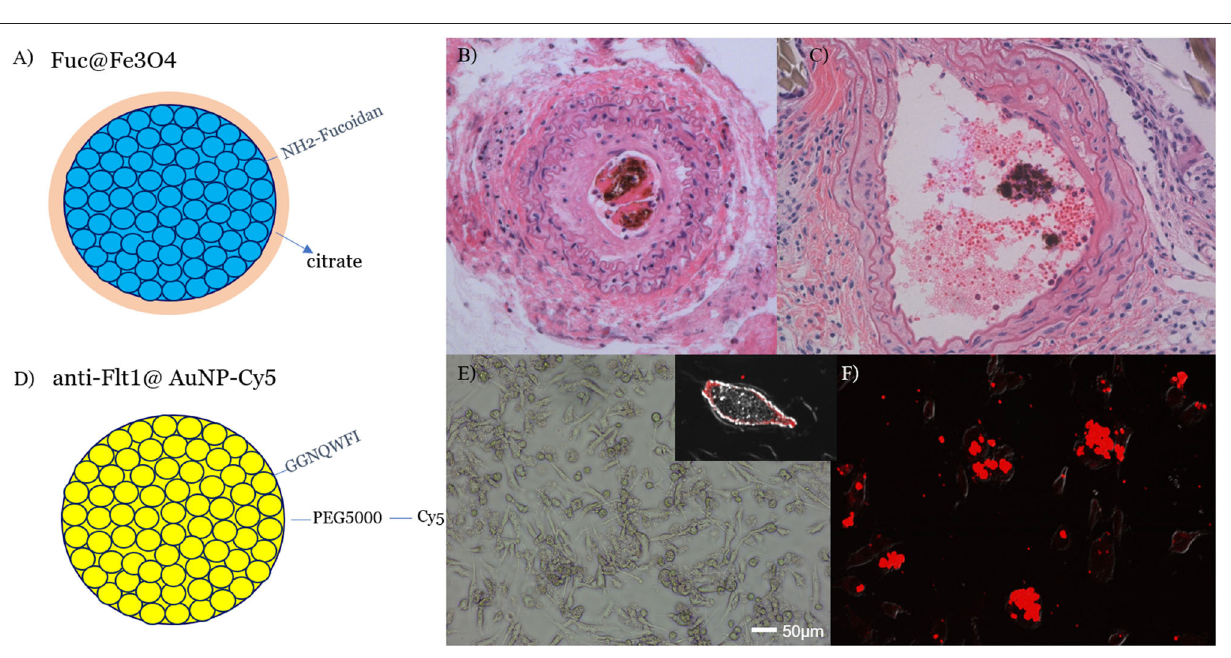
Frontiers in Physics |